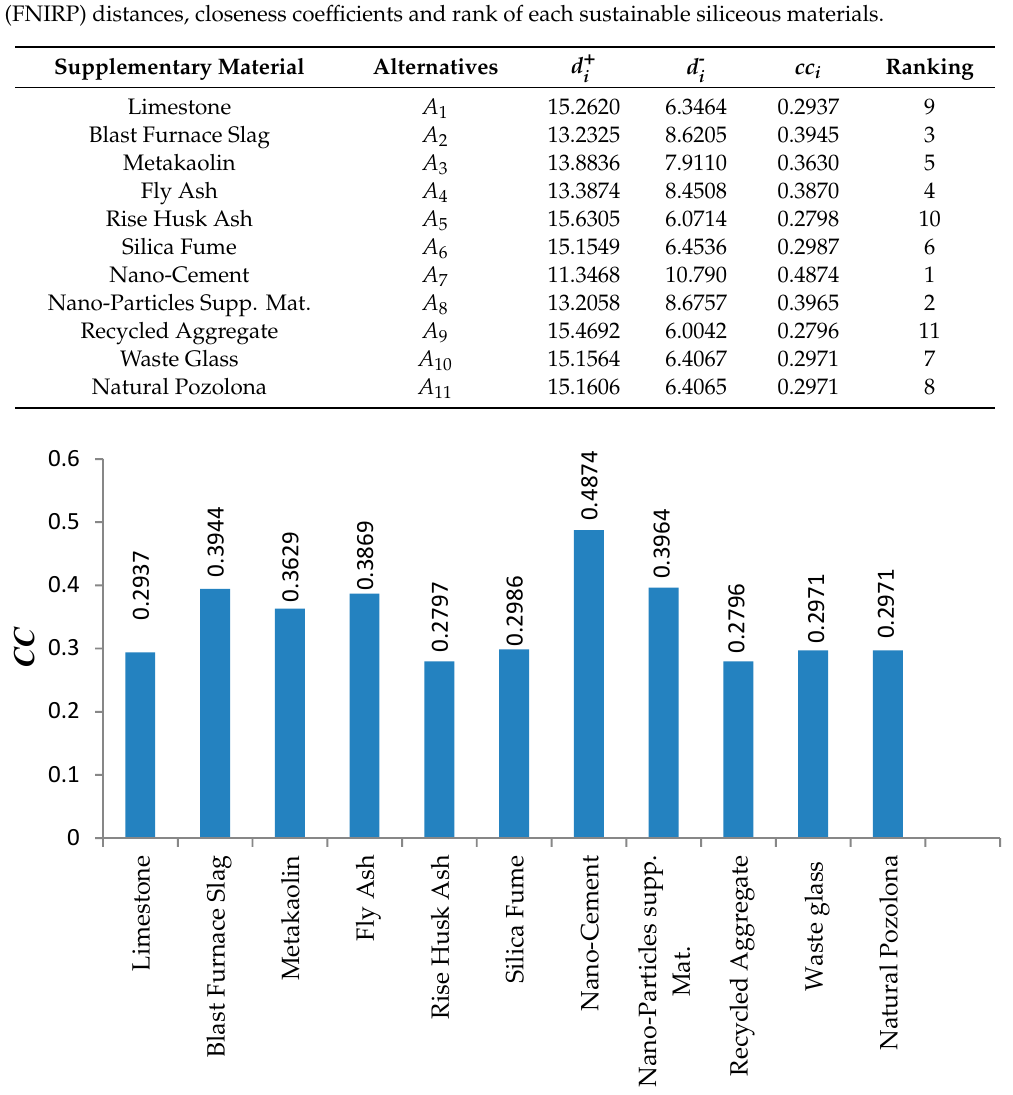
Figure 2. Ranking of each alternative material based on closeness coefficient.